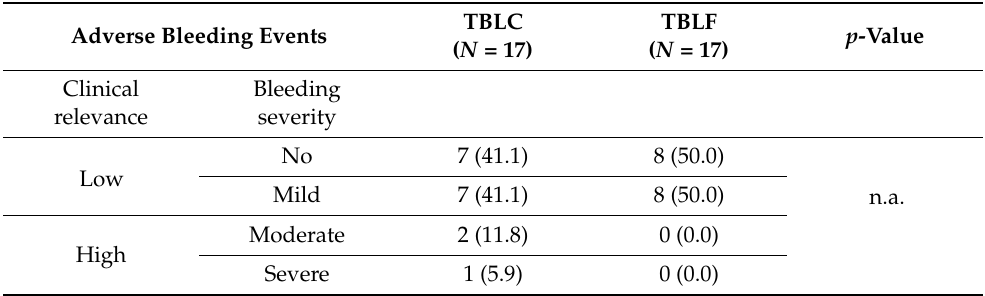
Table 3. Adverse bleeding